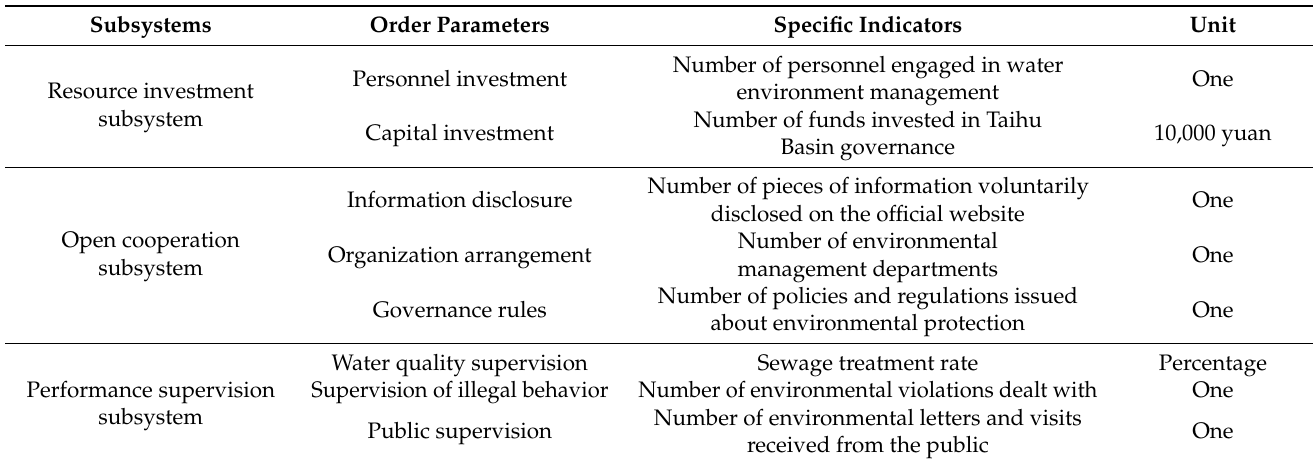
Figure 3. Evolution model of the WCG system. Table 1. Evaluation index system of WCG.